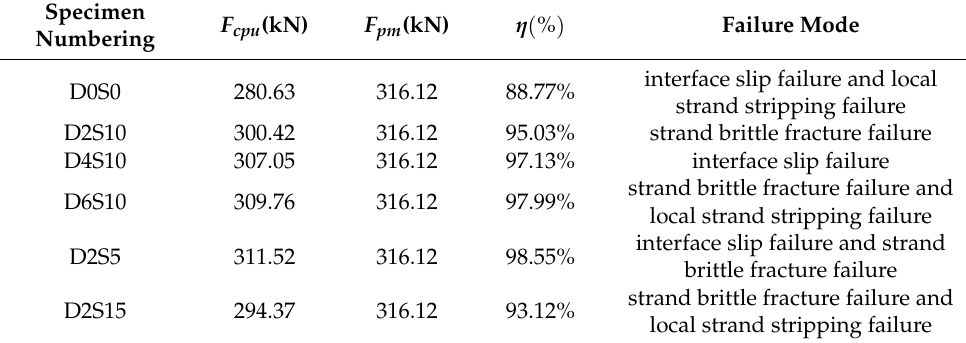
Figure 7. Typical failure mode of specimen: ( a ) D0S0-anchorage zone; ( b ) D2S10-anchorage zone; ( c ) D4S10-anchorage zone; ( d ) D6S10-anchorage zone; ( e ) D2S5-anchorage zone; ( f ) D2S15-anchorage zone; ( g ) middle point of the free section; ( h ) cross-section of anchorage zone. Table 3. Summary of test results.